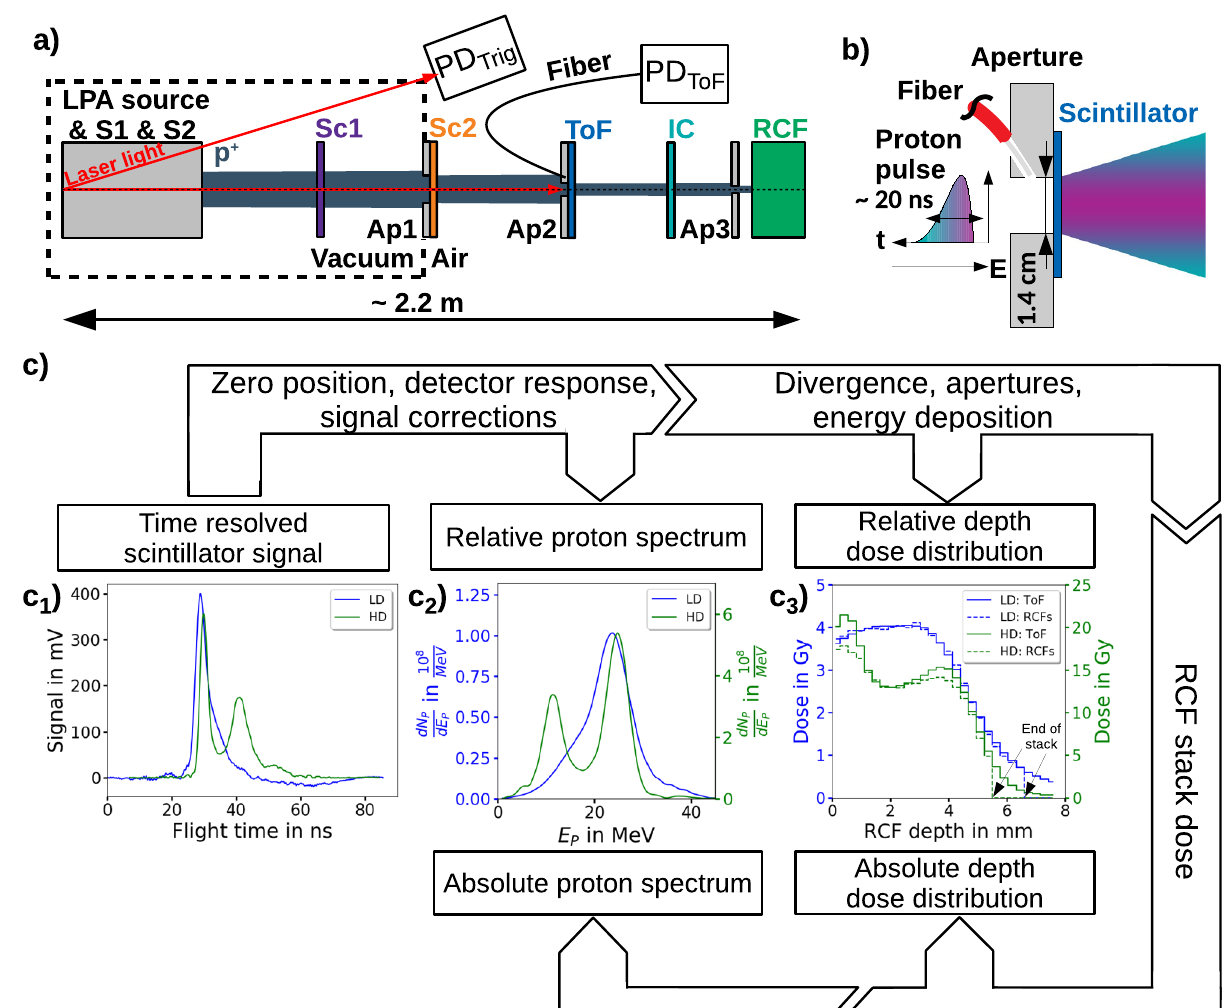
Figure 1. The setup and the operation of the time-of-flight (ToF) beam monitoring system (BMS) installed at the ALBUS-2S beamline for monitoring the transported kinetic proton energy spectrum of two different beamline settings (low dose per pulse (LD, blue lines) and high dose per pulse (HD, green lines)). ( a ) The ALBUS-2S beamline consisting of the laser plasma-based accelerator (LPA) source, two pulsed solenoids (S1 and S2) for proton beam transport and energy selection, several scatterers (Sc1 and Sc2) and apertures (Ap1, Ap2,Ap3) for beam homogenization and shaping 29 , the ToF BMS, the ionization chamber (IC) and radiochromic films (RCFs) for beam monitoring and dosimetry. The photodiode PD Trig is used for triggering the ToF BMS and the photodiode PD ToF for the ToF measurement. ( b ) The 20 ns -long proton pulse arrives at the ToF scintillator position with a lateral diameter of 30 mm with the most energetic protons at the leading pulse edge due to flight time broadening. The proton divergence after the ToF aperture (illustrated with the colored cone) decreases with increasing kinetic proton energy, resulting from chromatic focusing of the solenoids and the kinetic energy dependent scattering behavior of the protons. ( c ) Workflow for obtaining the calibrated kinetic proton energy spectrum. Here, the measured time resolved PD ToF signal is used to calculate the proton flight time signal shown in c 1 ) and the relative kinetic proton energy spectrum. The forward simulation of the relative kinetic proton energy spectrum is used to predict the relative depth dose distribution in the RCF stack at the irradiation site. Comparison with the depth dose distribution measured with a calibrated RCF stack ( c 3 )) yields a calibration factor for the ToF BMS for obtaining the calibrated kinetic proton energy spectrum shown in c 2